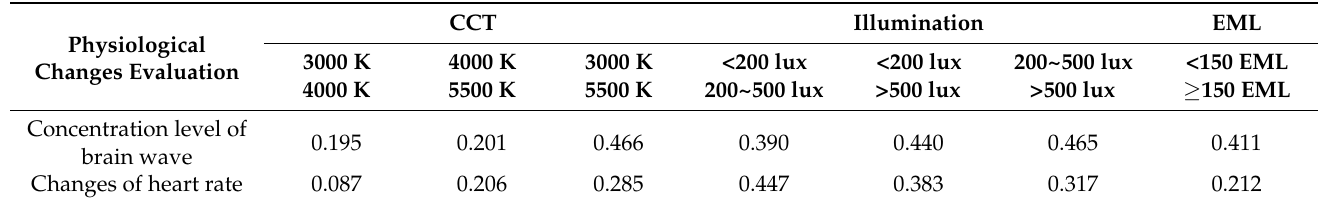
Table 4. Significant ( p ) results of T -test for physiological changes